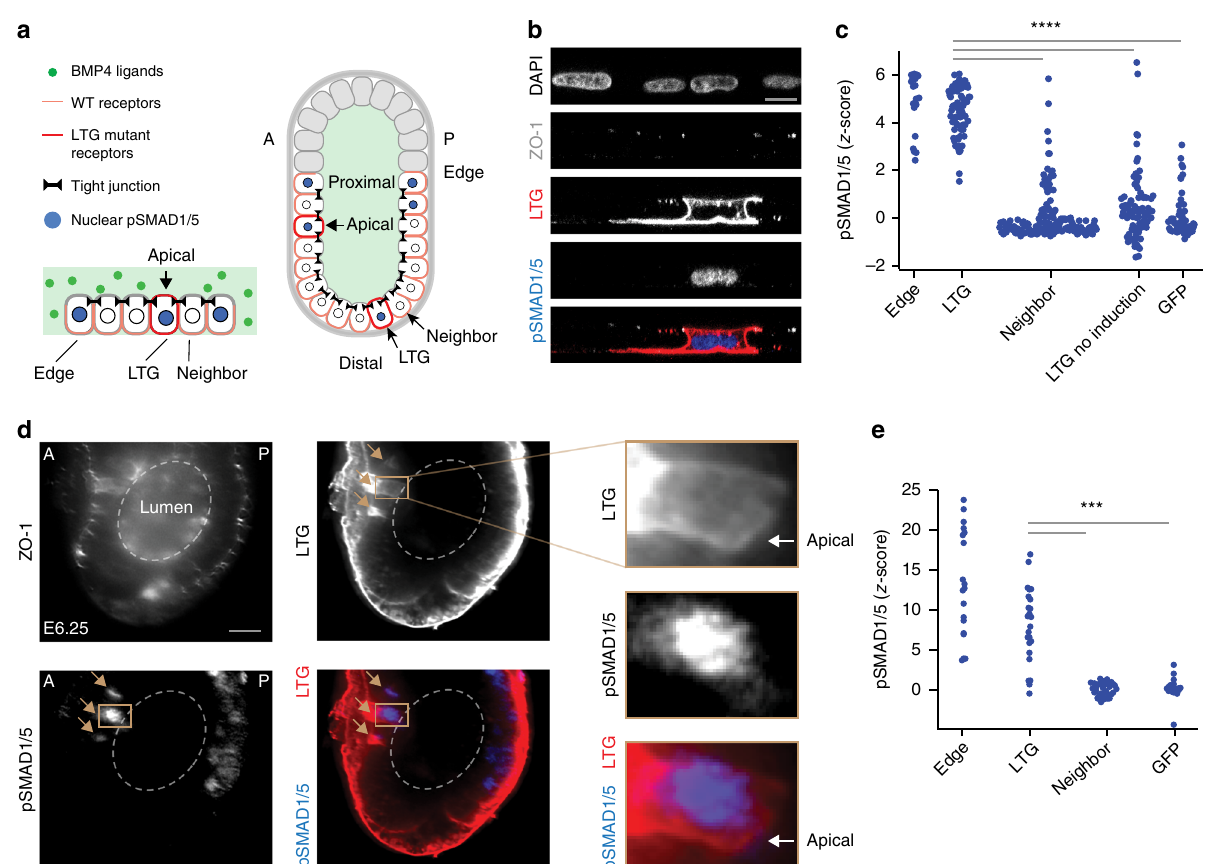
Fig. 6 Mis-localization of receptors leads to ectopic BMP signaling. a Left: Illustration of a hESC colony containing a single cell with mis-localized LTG mutant BMP receptors, exposed to BMP4 ligands. Right: Illustration of mouse embryo with two cells expressing mis-localized LTG mutant BMP receptors, leading to ectopic pSMAD1/5 activity. A and P denote anterior and posterior, respectively. b Confocal image of hESC colony transfected with mutant receptor plasmid (BMPR1A A514G -Clover-IRES-BMPR2 A494G ), immunostained for pSMAD1/5 after a 30 min BMP4 induction. From top: DNA, ZO-1, Clover (LTG mutant receptors), pSMAD1/5, and color-combined image. Scale bar 10 µ m. c pSMAD1/5 intensities of hESCs after 30 min BMP4 induction: cells at edge of colony (Edge, n = 23 from two experiments); non-edge cells expressing mutant BMPR1A A514G and BMPR2 A494G receptors (LTG, n = 73 from two experiments); non-transfected neighbors of transfected cells (Neighbor, n = 166 from two experiments); cells expressing mutant receptors but without BMP4 induction (LTG no induction, n = 96 from two experiments); and cells transfected with GFP plasmid ( n = 51 from two experiments). Z -score denotes number of standard deviations beyond background mean (of neighboring non-transfected cells), **** p < 0.0001 (paired t -test). d E6.25 mouse embryo transfected with mutant receptor plasmid (BMPR1A A514G -Clover-IRES-BMPR2 A494G ), immunostained for ZO-1, Clover (LTG mutant receptors), and pSMAD1/5. Images show localization of mutant receptors at both apical and basolateral membrane and pSMAD1/5 activity in a transfected cell. Brown arrows indicate transfected cells. Scale bar 20 µ m. e pSMAD1/5 intensity epiblast cells: cells at edge of epiblast (Edge, n = 42 from 13 embryos); non-edge cells transfected with mutant receptor plasmid (LTG, n = 27 from 13 embryos); their neighboring non-transfected cells (Neighbor, n = 52 from 13 embryos); and cells transfected with a GFP plasmid (GFP, n = 20 from 3 embryos). Edge and LTG cells with z -score greater than 25 are not shown ( n = 26), *** p < 0.001 (paired t